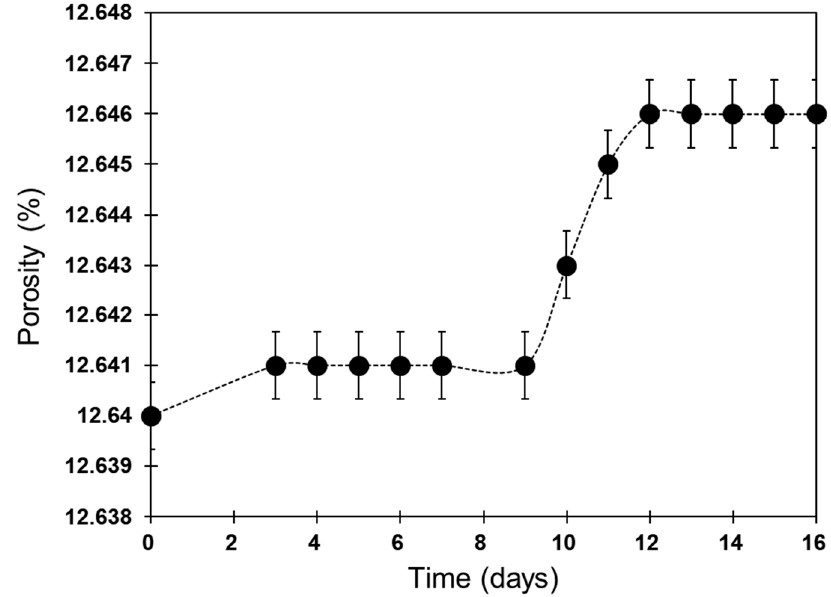
Figure 6. Porosity changes over time in the numerical simulation.